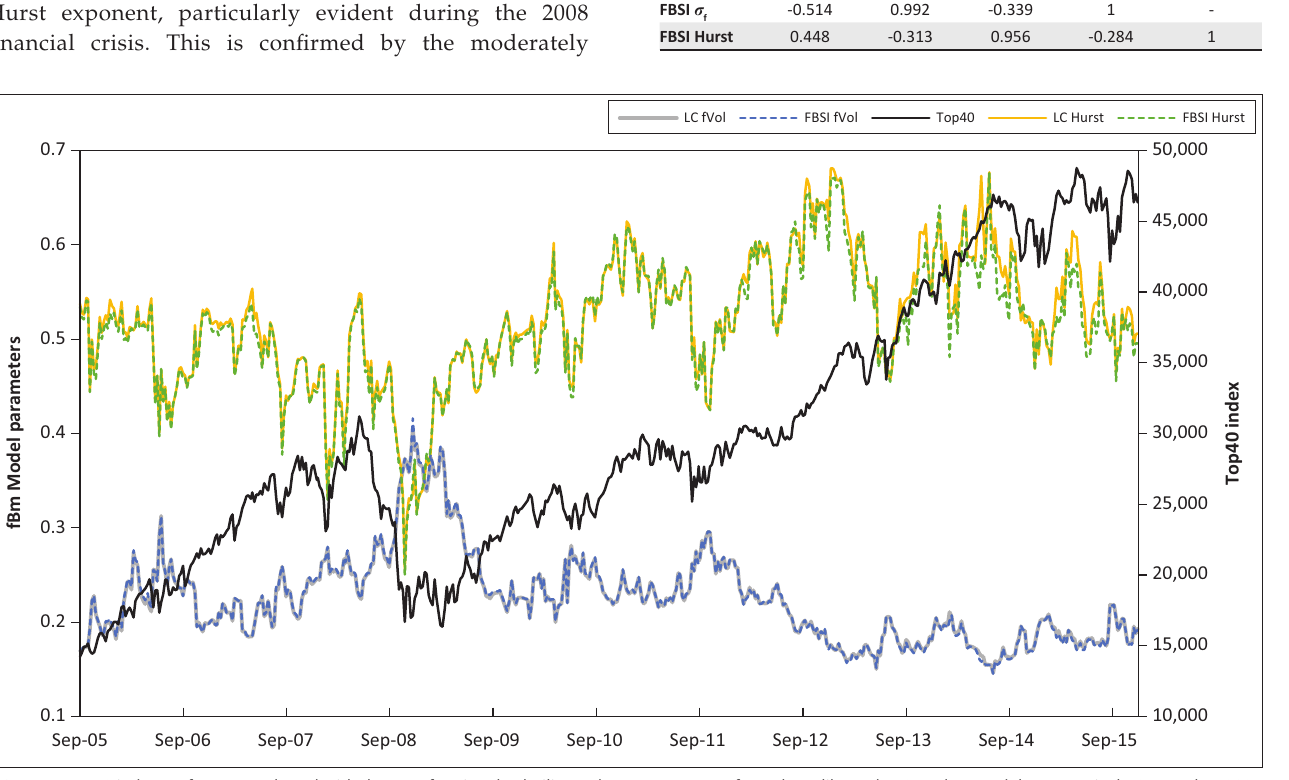
FIGURE 4: Top40 index performance plotted with the ATM fractional volatility and Hurst exponents from the calibrated FBSI and LC models, respectively, September 2005 to November 2015.